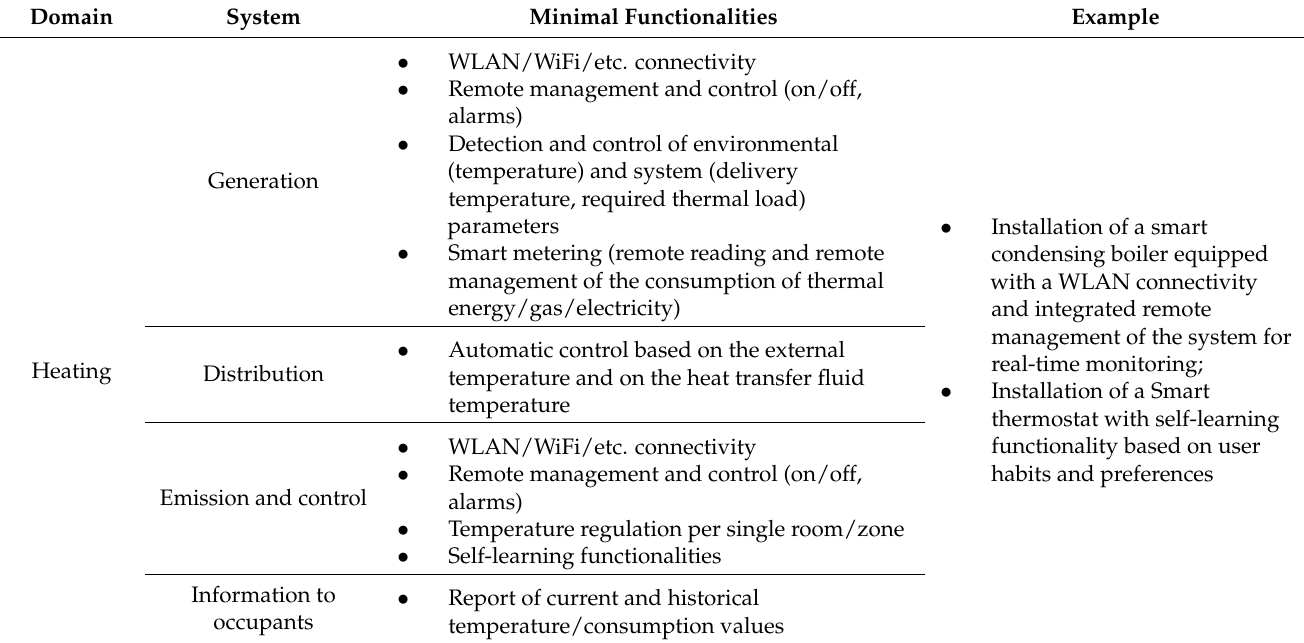
Table 5. Functionality levels of the “smart energy